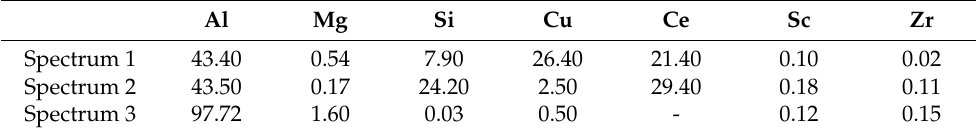
Figure 3. ( a ) TEM micrographs of the eutectic originated particles in the as-homogenized 4Ce alloy; ( b ) the TEM-EDS spectrums for the areas 1–3 marked-up with circles in ( a ). Table 2. Elemental composition (at.%) corresponded to the spectrums 1–3 in Figure 1b.